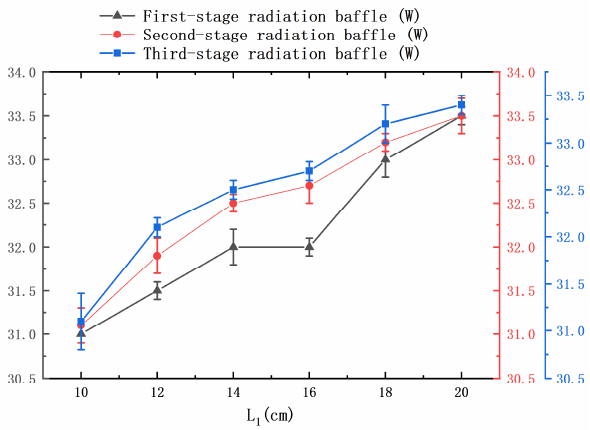
Figure 20. The absorbed radiation of three-stage cryopanels versus L 1 .